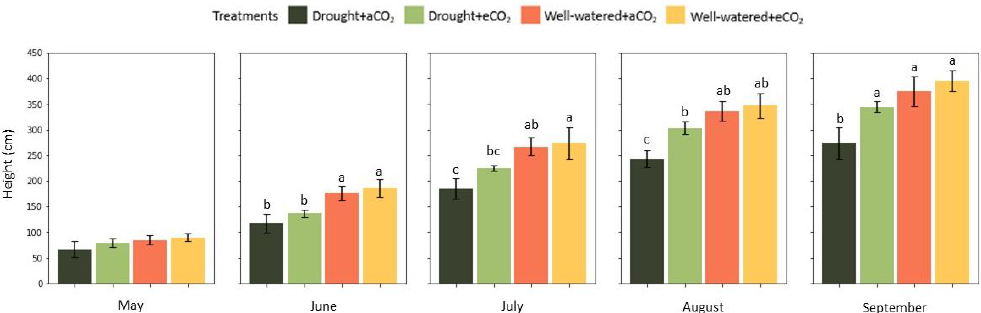
Figure 3. Effect of elevated CO 2 (950 ppm) and cyclic drought stress in the mean month value (± confidential level of 95%) of Eucalyptus grandis height during the growth season. Different small letters indicate statistical significance between the means ( p < 0.05).